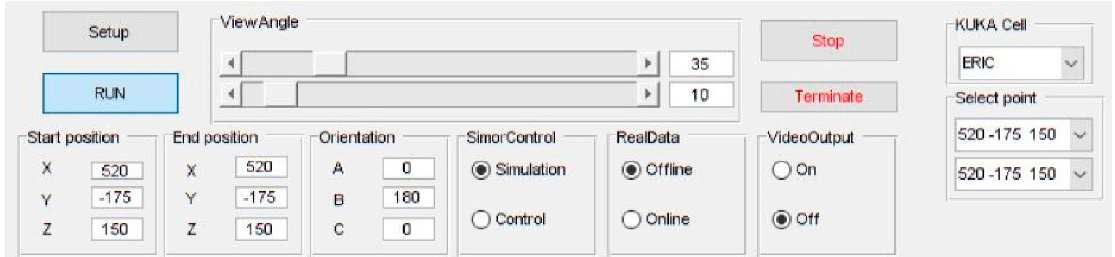
Figure 14. Main controls in the MATLAB GUI for the real-world physical demonstrator.